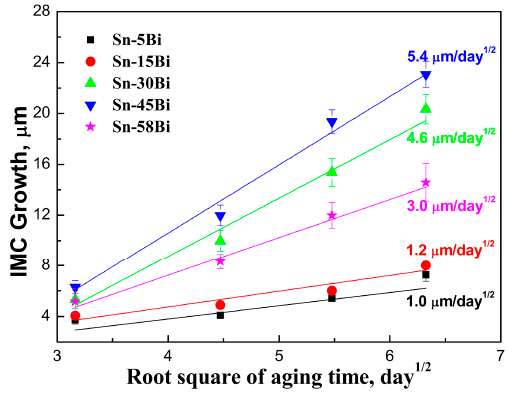
Figure 7. Linear relationship between the thickness of total IMC and the square root of aging days in Sn-Bi solder joints.